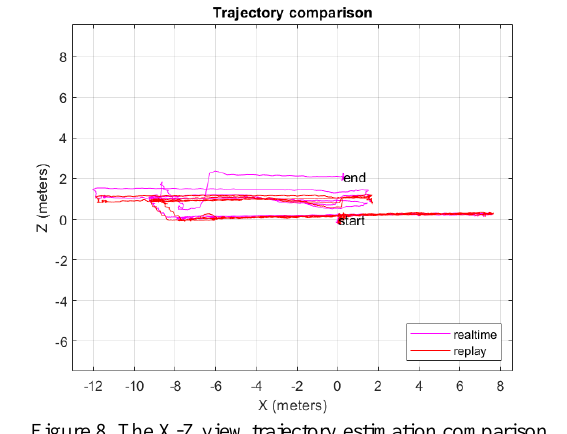
Figure 8. The X-Z view trajectory estimation comparison between real-time and replay